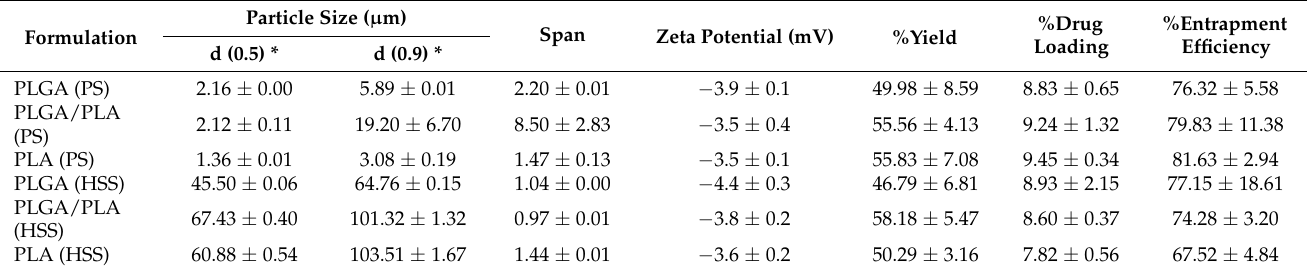
Table 1. Characteristics of ketorolac-loaded